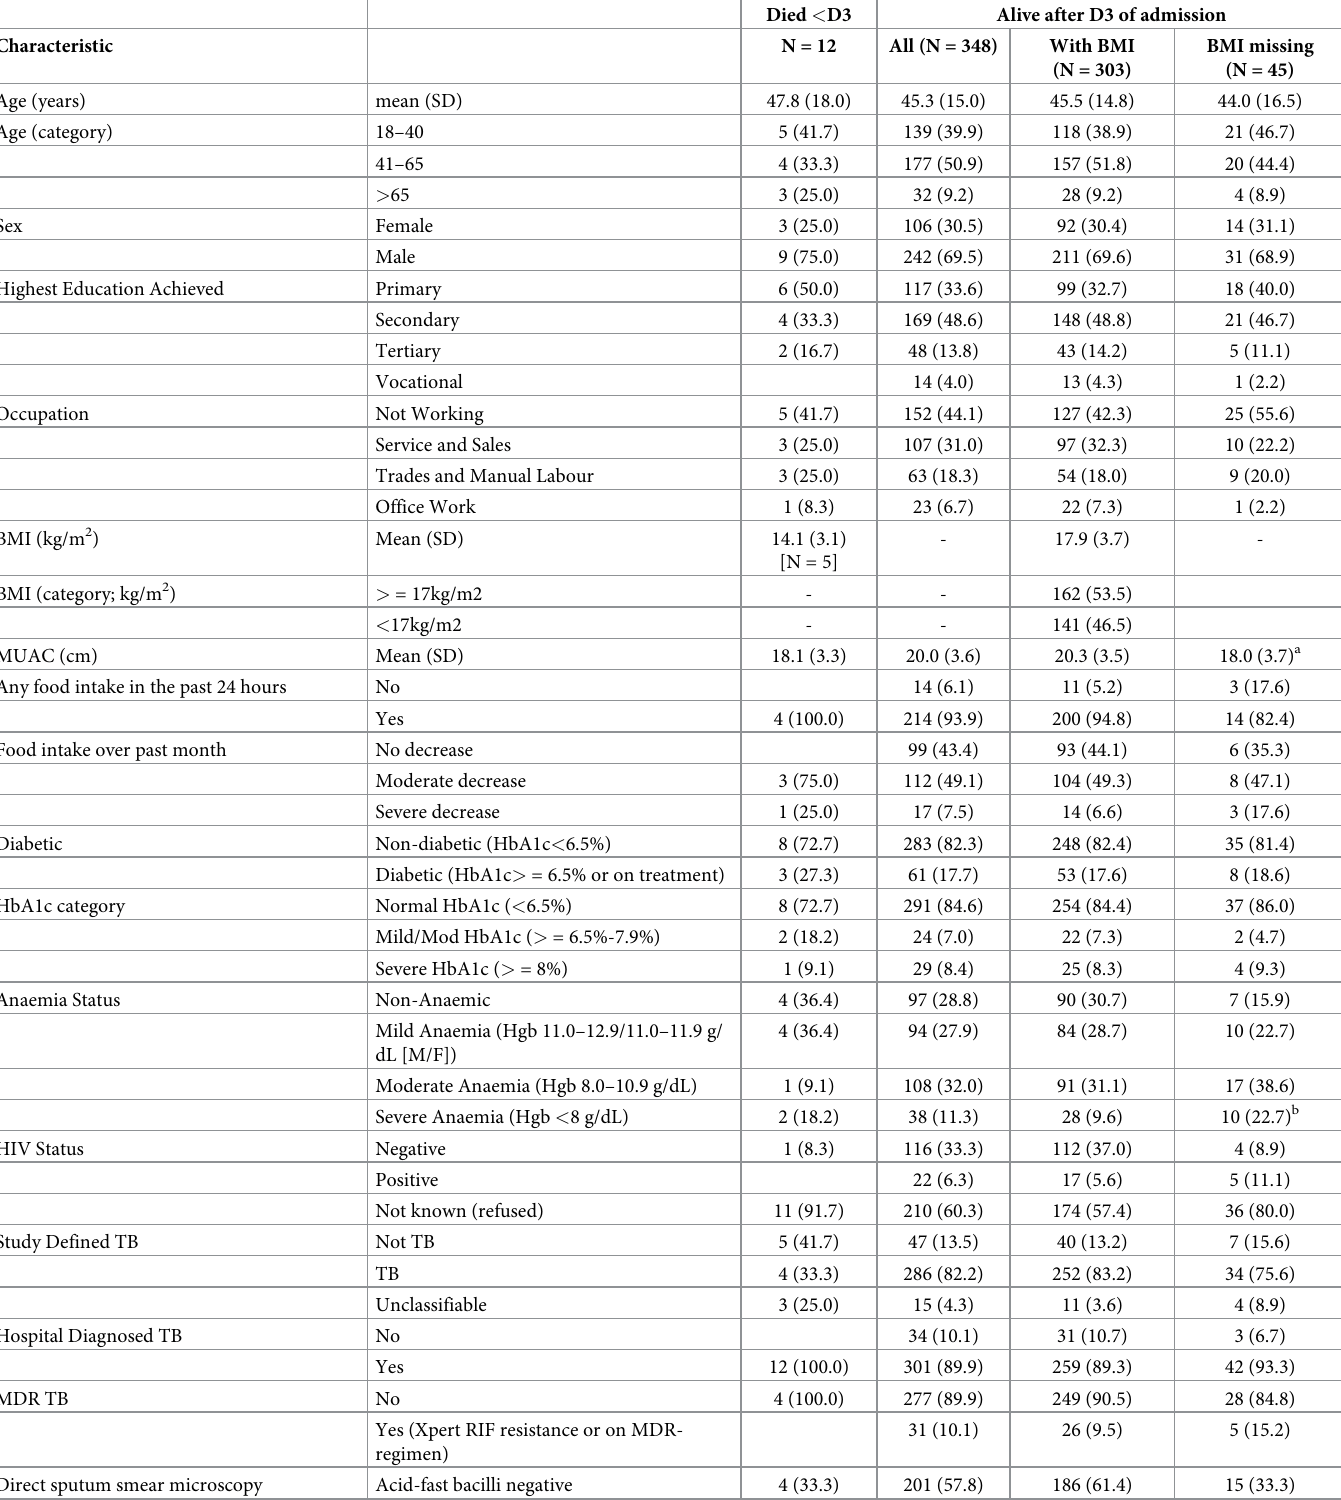
Table 1. Characteristics of study